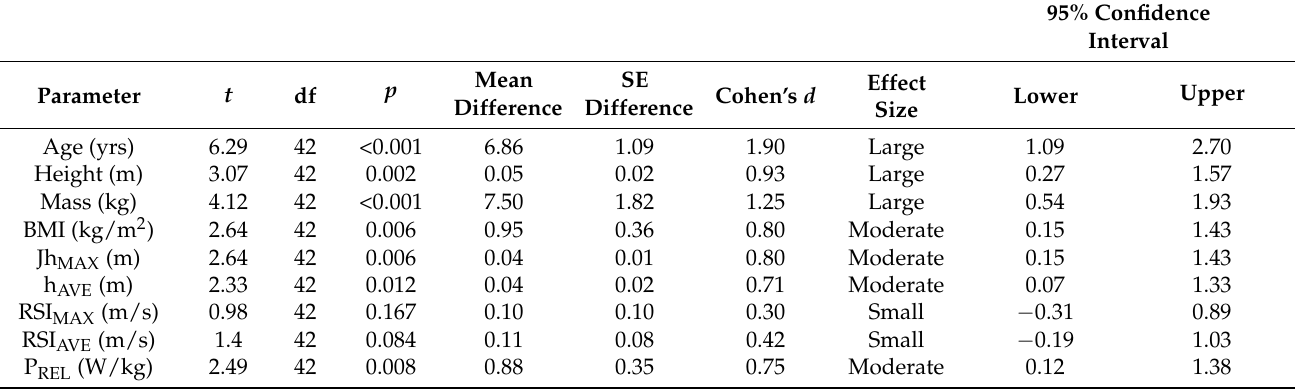
Table 2. Independent Samples T-Test and Cohen’s d Effect Size.